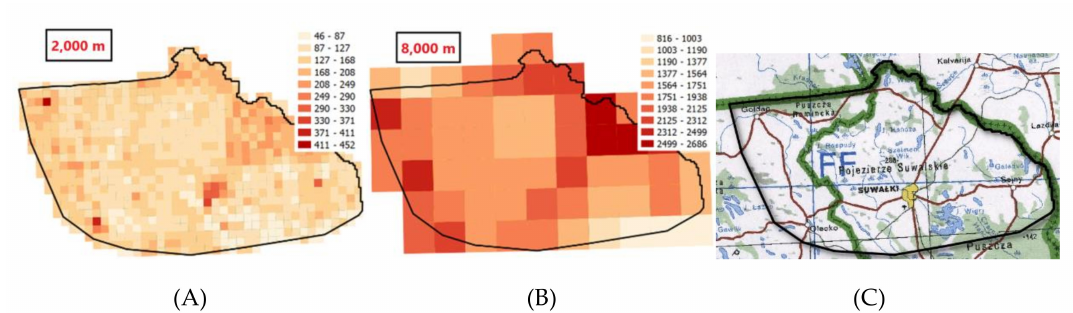
Figure 6. 2000 × 2000 m ( A ) and 8000 × 8000 m ( B ) fields with a number of objects and its comparison with the content of the map ( C ).